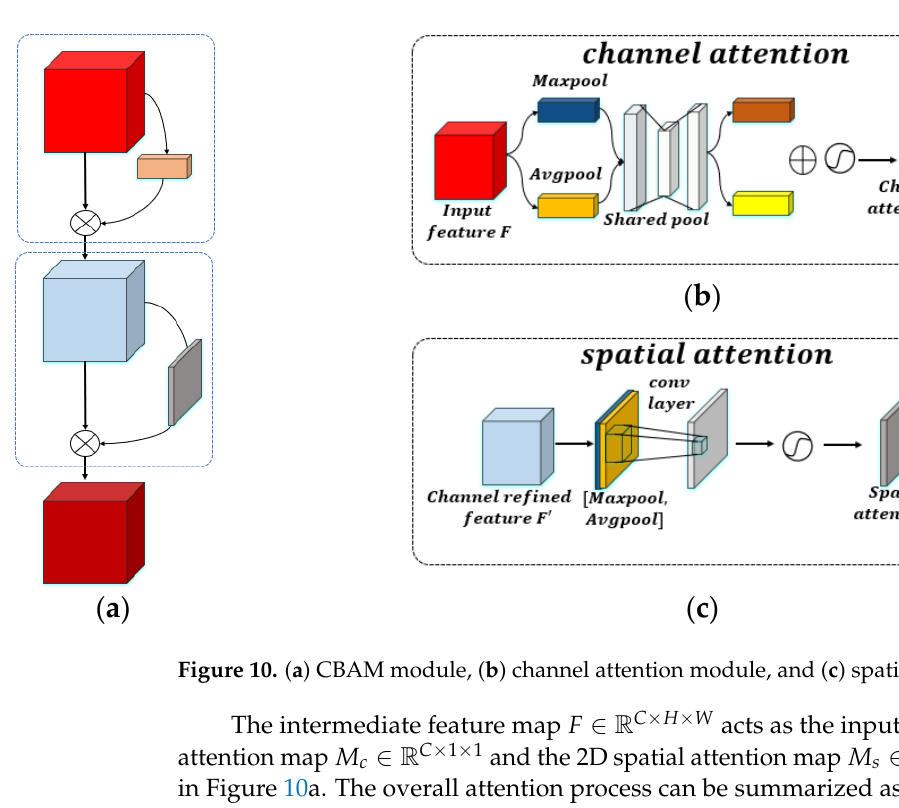
∈ ℝ (cid:2869)×(cid:3009)×(cid:3024) , as illustrated (cid:3046)